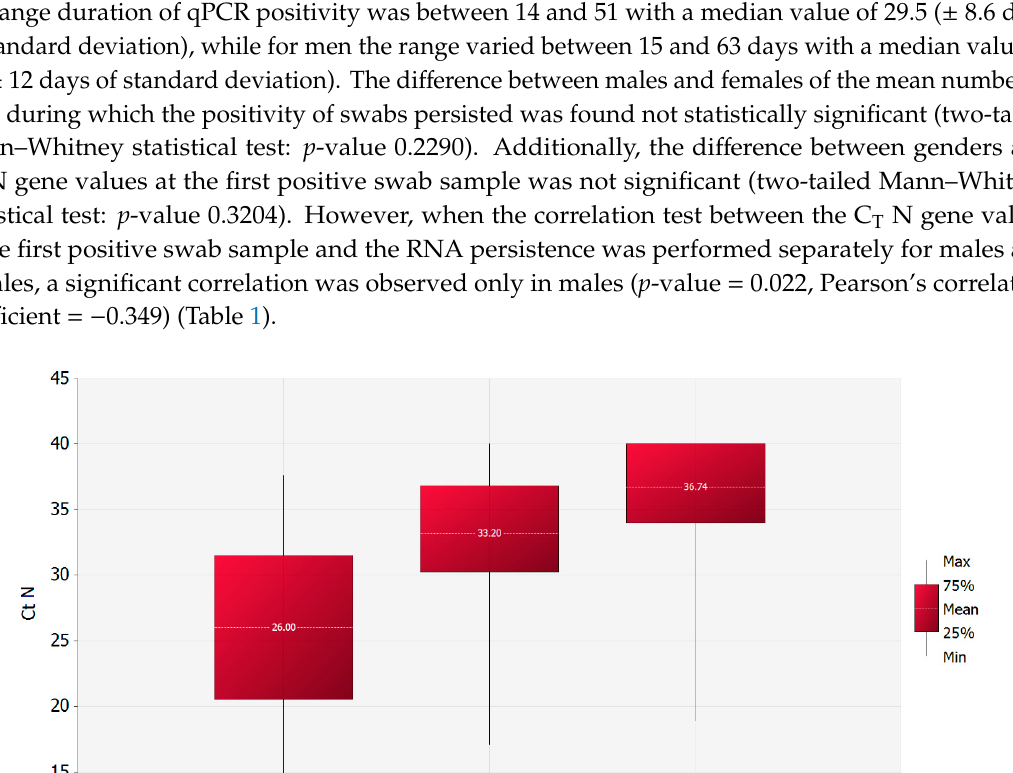
Figure 5. Scatterplot of C T N gene values at the first positive swab and the SARS-CoV-2 RNA persistence in naso-pharyngeal/oropharyngeal swabs per patient.